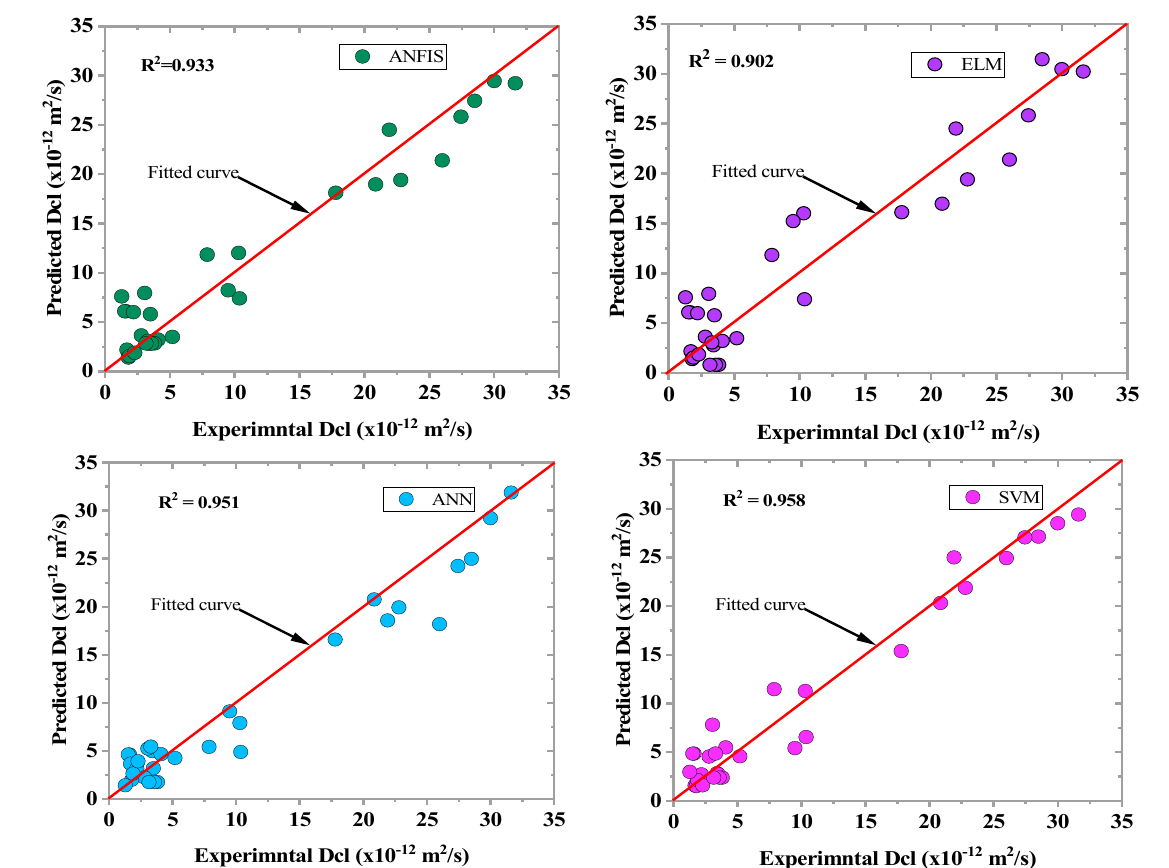
Figure 9. Predicted vs. measured plots of the ML models in the testing phase.